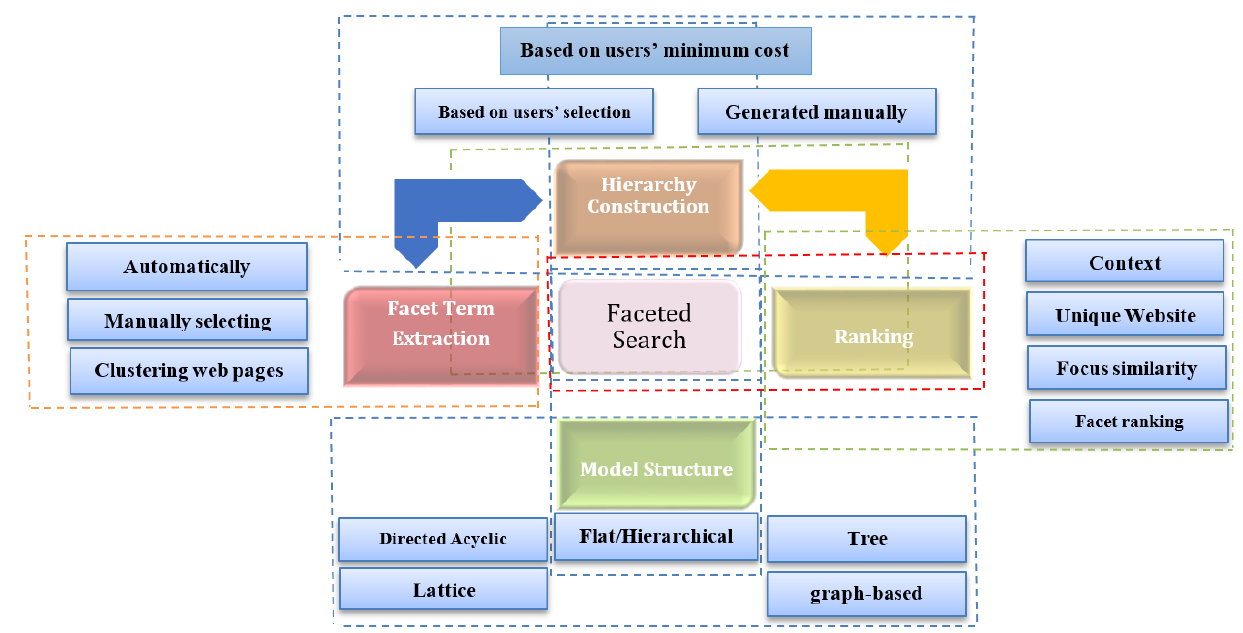
Figure 12. General framework. for a faceted search